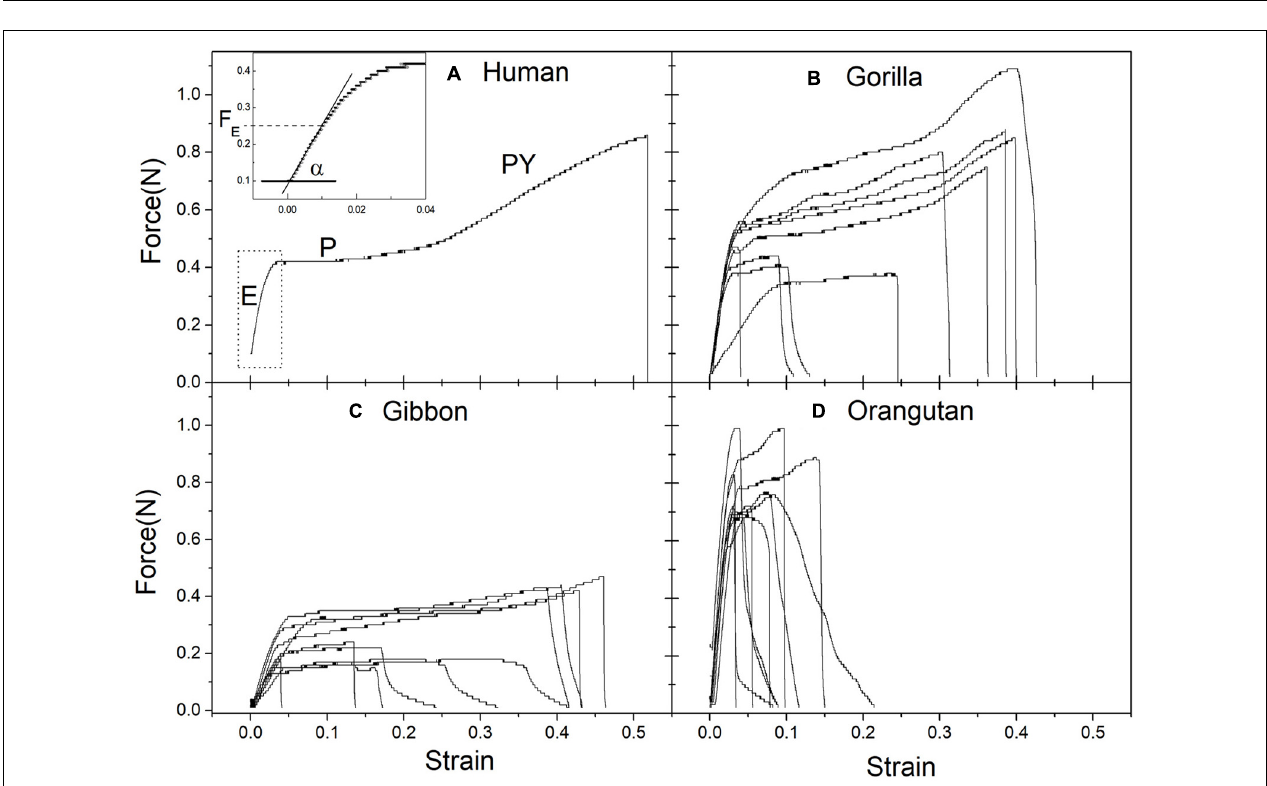
along our evolutionary line was already published and will